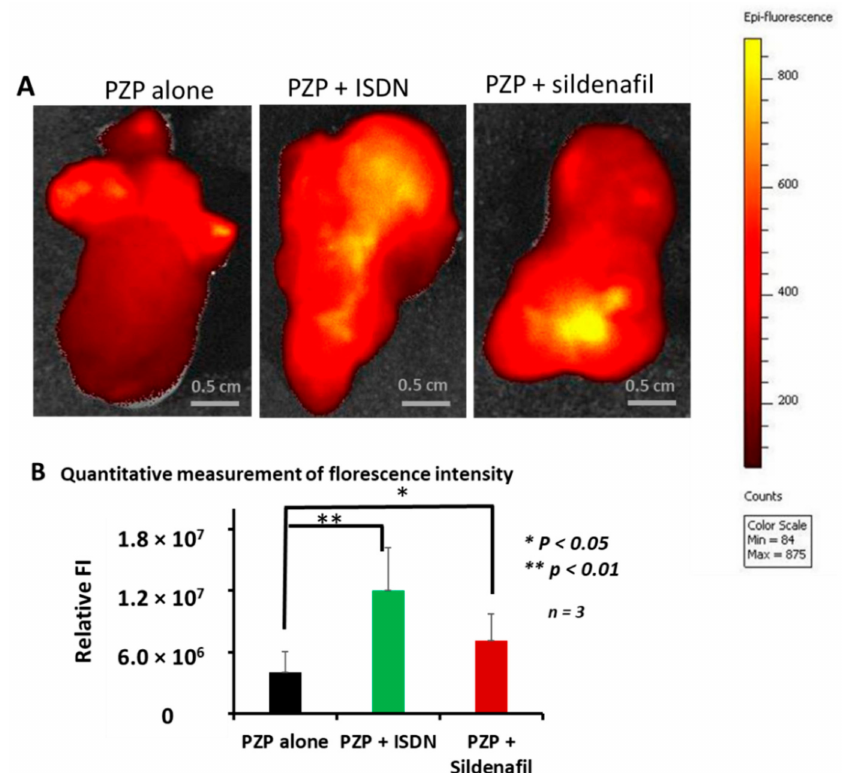
Figure 3. Ex vivo imaging of advanced mouse tumors after treatment with PZP plus ISDN or sildenafil. To study EPR-effect enhancers, we used late-stage C26 tumors (about 18 mm in diameter). PZP, 5 mg/kg, was injected iv, after which ISDN or sildenafil was administered. After 24 h of iv infusion, tumors were removed from mice, and fluorescence images were obtained by IVIS. Both enhancers augmented drug delivery to tumors about two- to three-fold ( A ). ( B ) shows the comparison quantitative measurement of PZP drug accumulation with/without EPR-effect enhancers based on the fluorescence intensity. Data are expressed as means ± SD ( n =